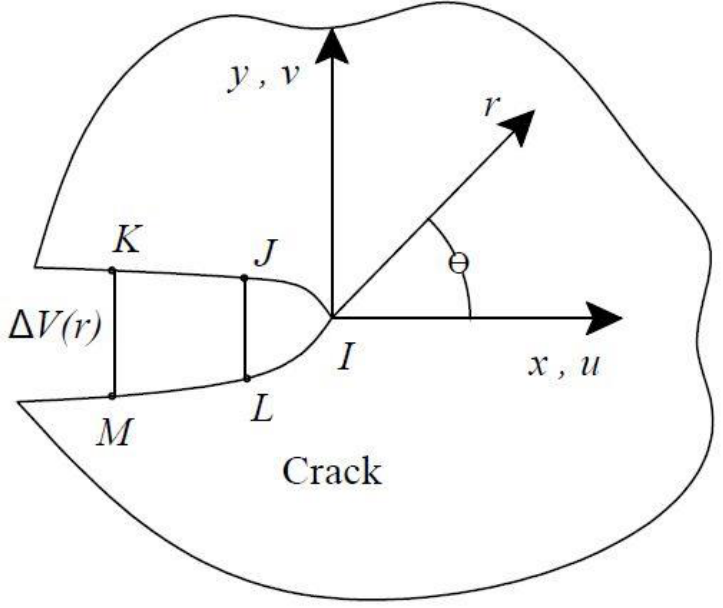
Figure 3. Approximate displacements of crack tip node. As shown in Figure 3, three nodes I , J and K are located on the crack surface. If point I is the coordinate origin, the displacement v at node I is zero. Then A and B can be determined using the following